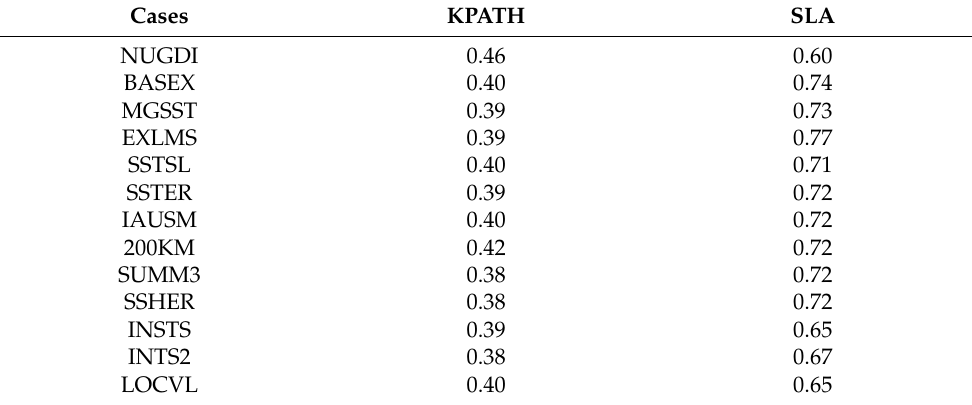
Table 6. Latitudinal RMSD (in degrees) between modeled and observed Kuroshio axis positions (see Figure 5 and Figure 12 for the examples) in a longitudinal range of 130 ◦ E–140 ◦ E for the period from 1 July to 31 August 2020 (KPATH: 2nd column), and mean correlation at the 11 tide gauge sites between modeled and observed sea level anomaly data for the same period. (SLA: 3rd